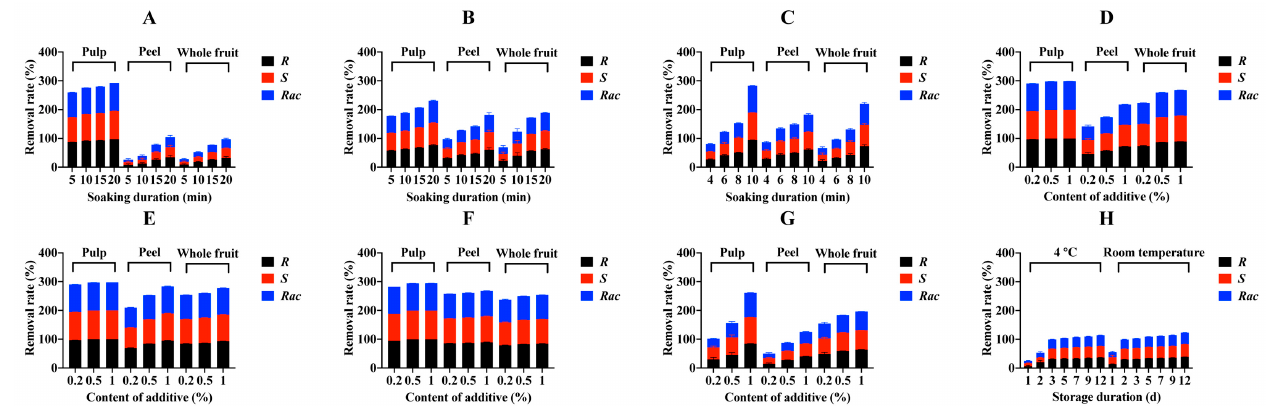
Figure 1. Rates of different soaking methods ( A ): water soaking and peeling; ( B ): heated water soaking and peeling; ( C ): ultrasound-assisted soaking and peeling; ( D ): water soaking with NaCl and peeling; ( E ): water soaking with AA and peeling; ( F ): water soaking with LAS and peeling; ( G ): water soaking with EA and peeling) and storing process at 4 °C and room temperature for different durations after saucing, ( H ) to remove penthiopyrad enantiomers from tomato samples.